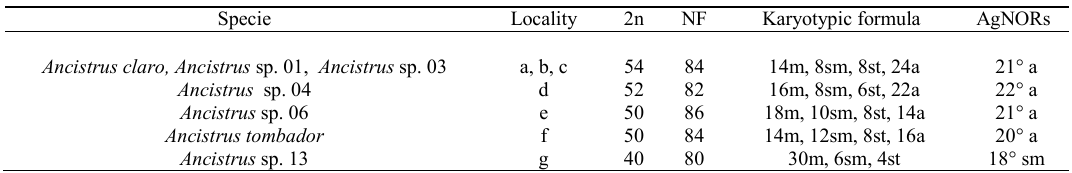
Table 2. Karyotype data of analyzed Ancistrus species in increasing diploid number order.